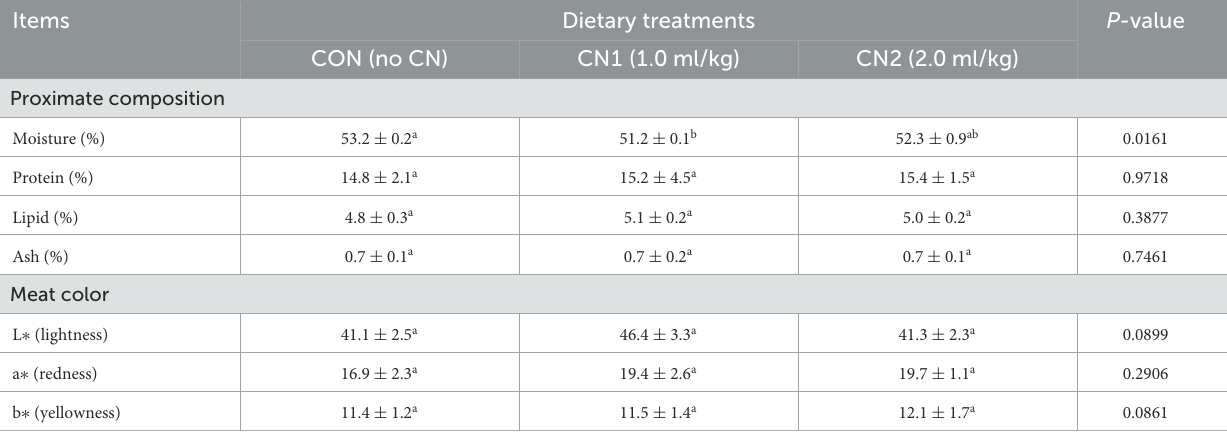
TABLE 3 Dietary curcumin nanospheres (CN) on meat quality of neck muscle in finishing pigs for 40 days 1 .